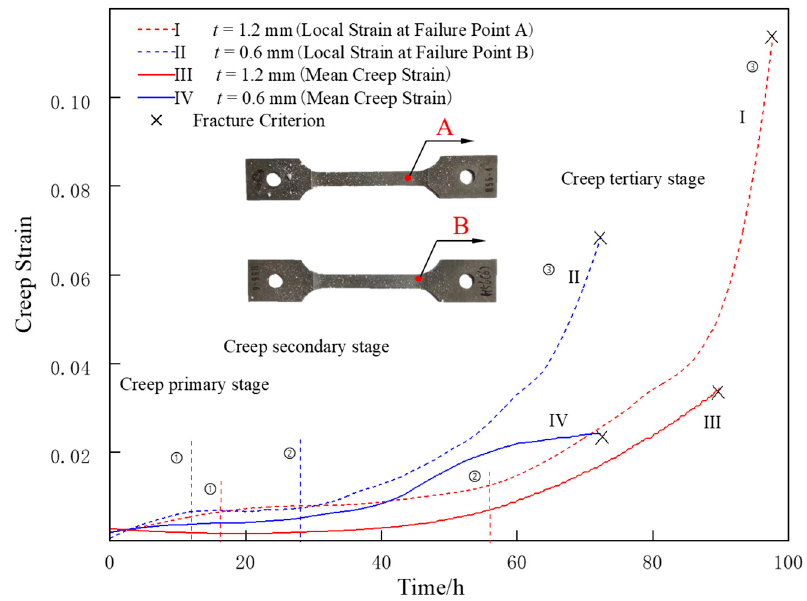
Figure 10. The curves of local strain vs. time and average strain vs. time of the thin-walled specimens of two thicknesses tested at 980 °C/250 MPa.